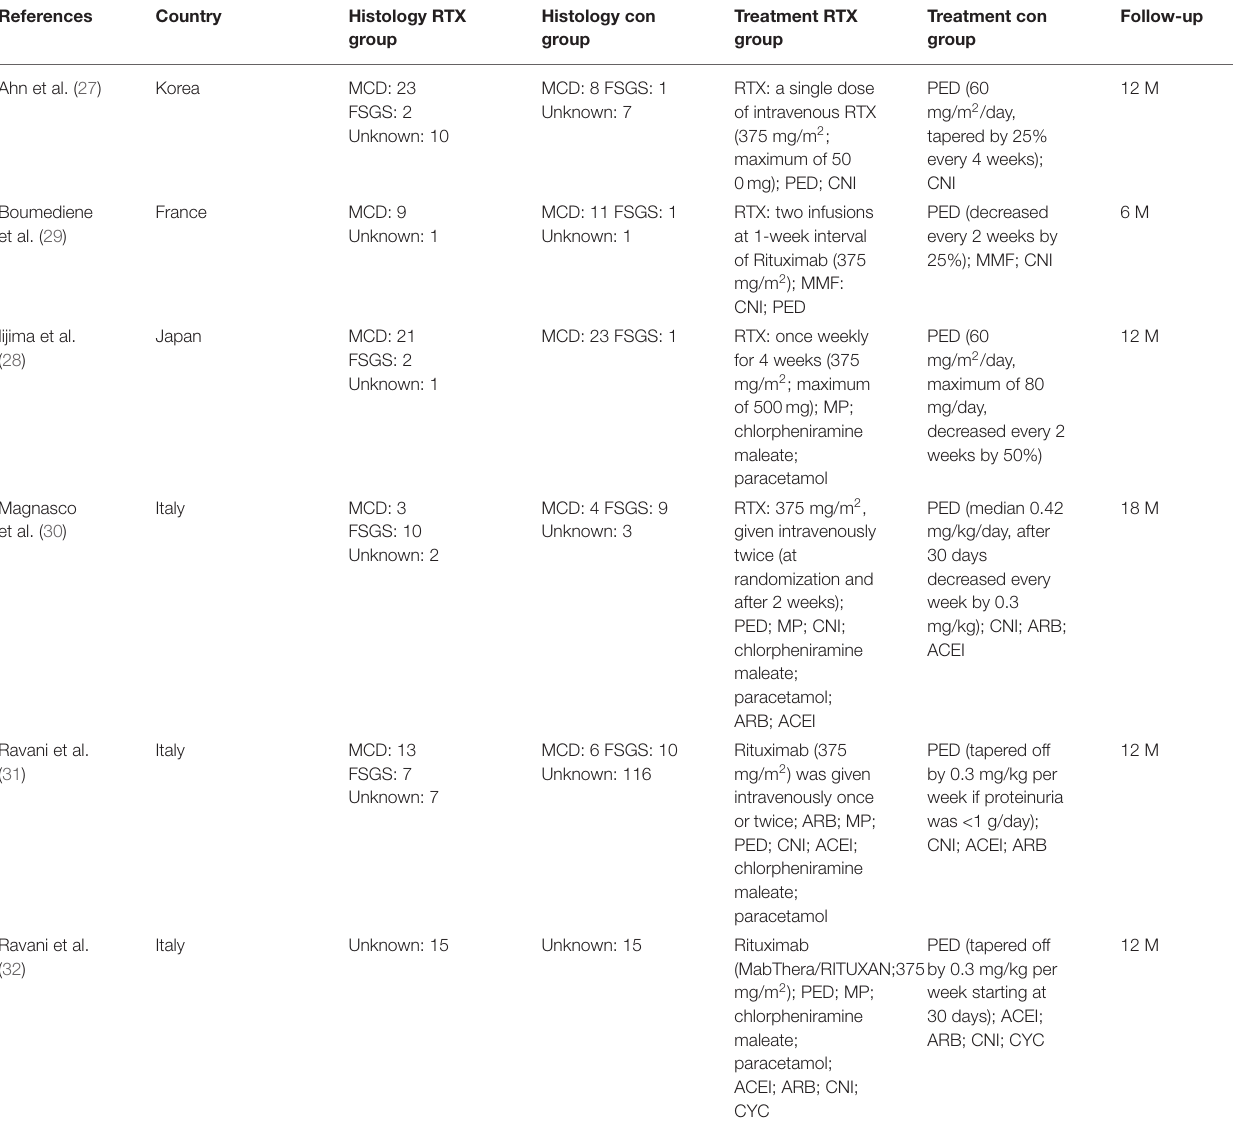
TABLE 1 | General information of the included